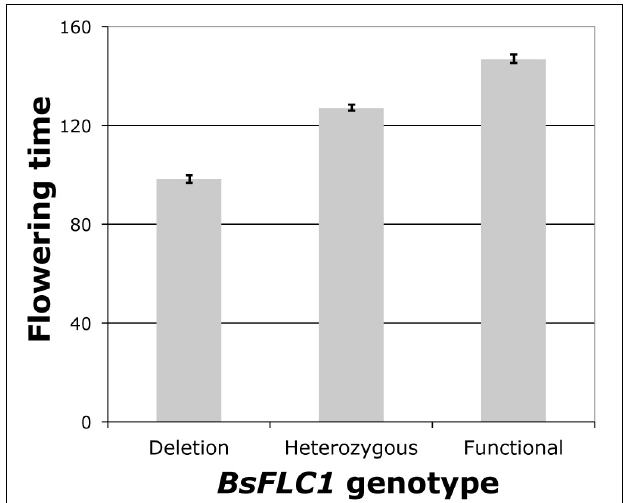
FIGURE 3 | BsFLC1 deletion significantly accelerates flowering ( P = 10 − 61 ) in 384 F2 individuals. Bars represent the mean and standard error of the days to first flower in three genotypes of a microsatellite marker 73 kb from BsFLC1 . All three bars are significantly different under the Tukey’s Honest Significant Difference